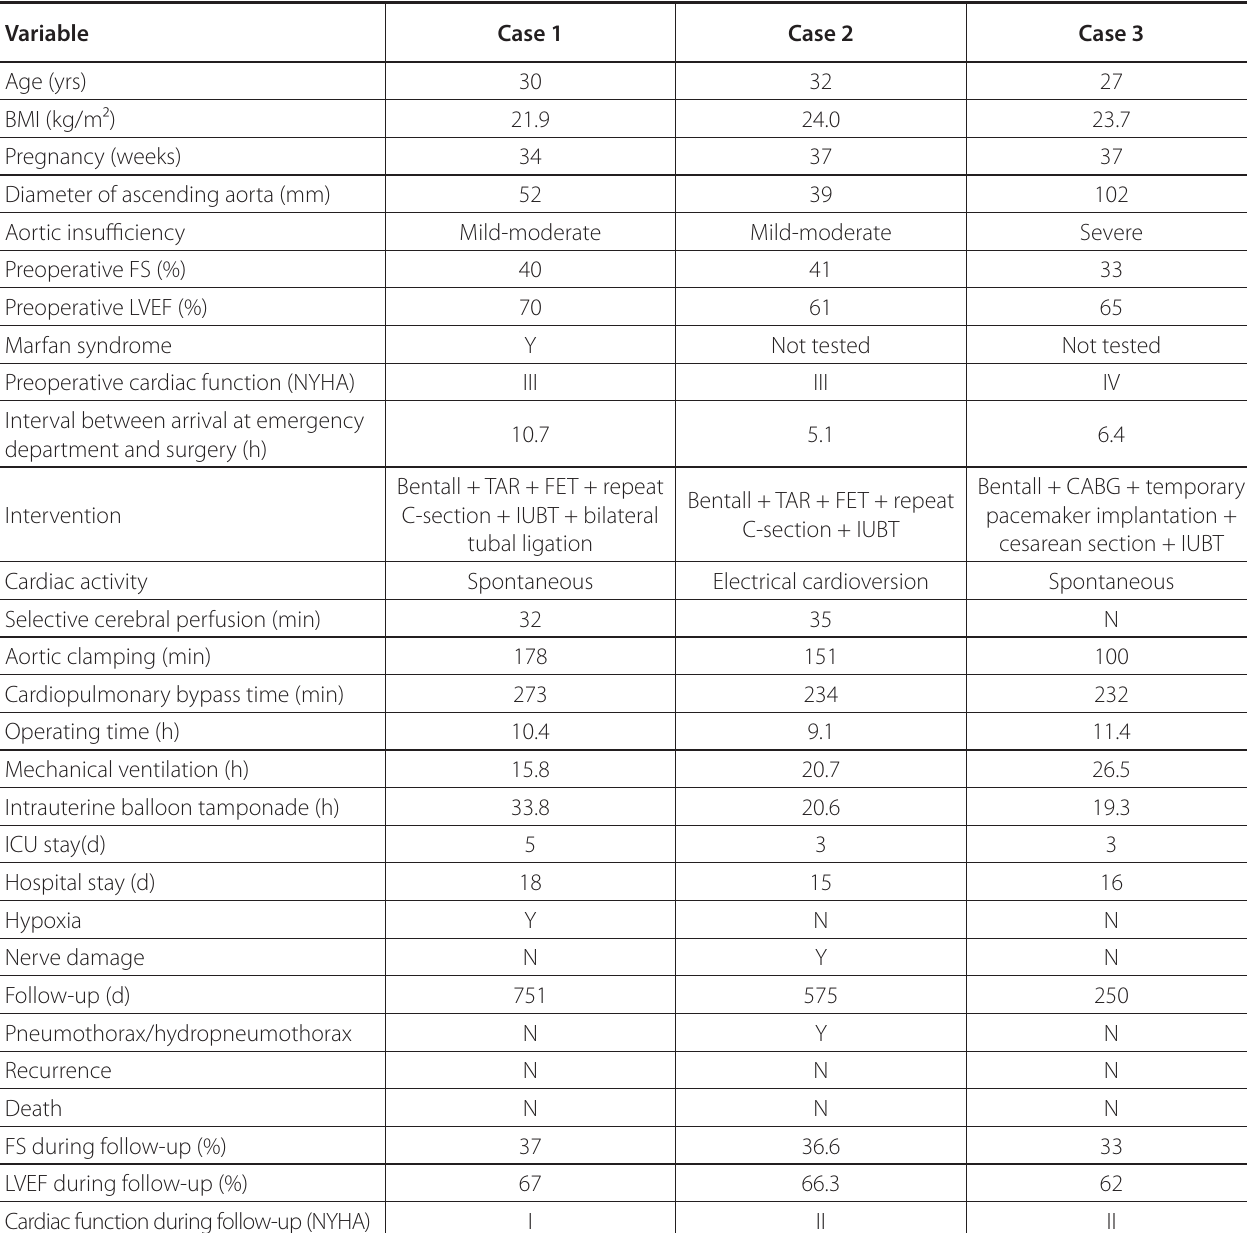
Table 1 . Clinical data of the